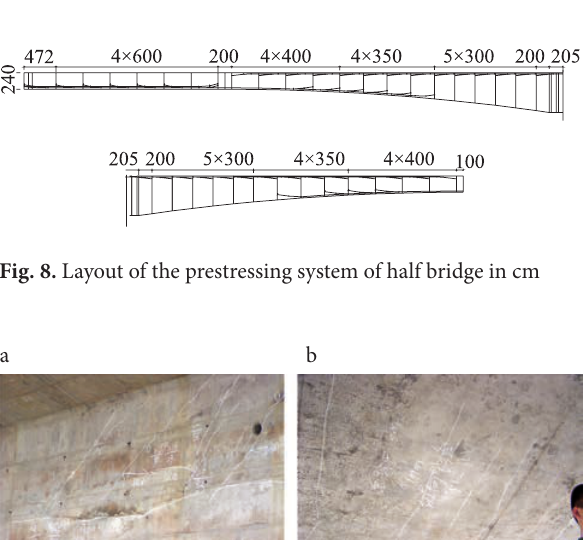
Fig. 7. Longitudinal profile of half bridge in cm